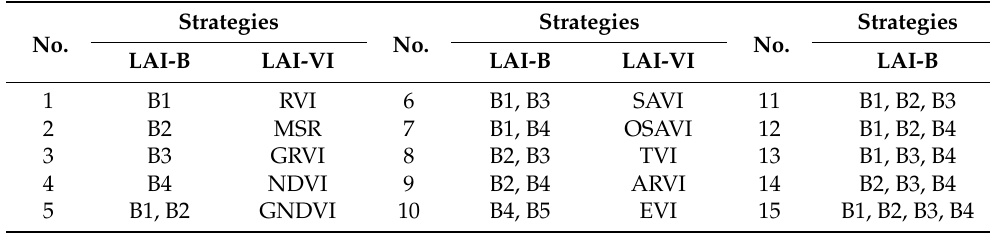
Table 4. Variable combinations for LAI